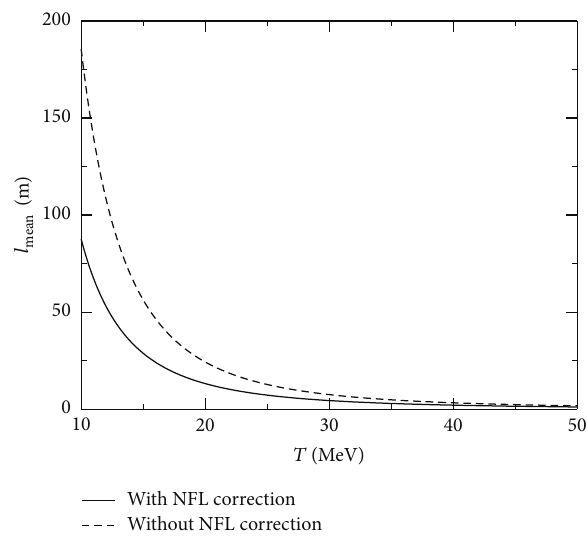
Figure 6: Neutrino mean free path in quark matter for nondegen- erate neutrinos